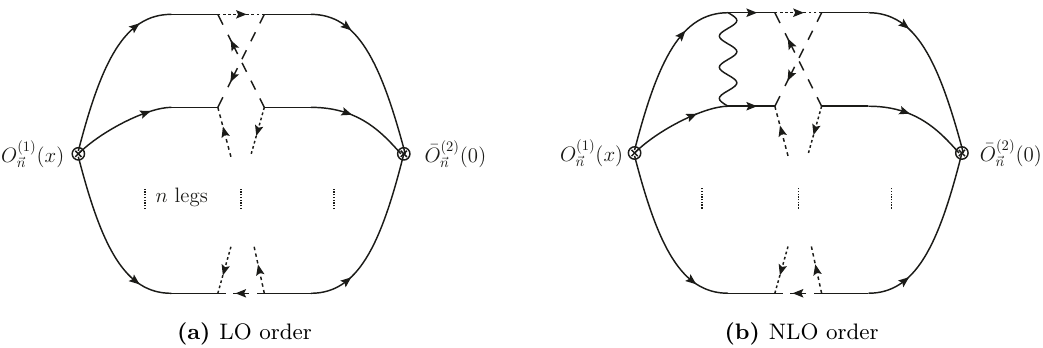
. The NLO includes all the ways of ~n